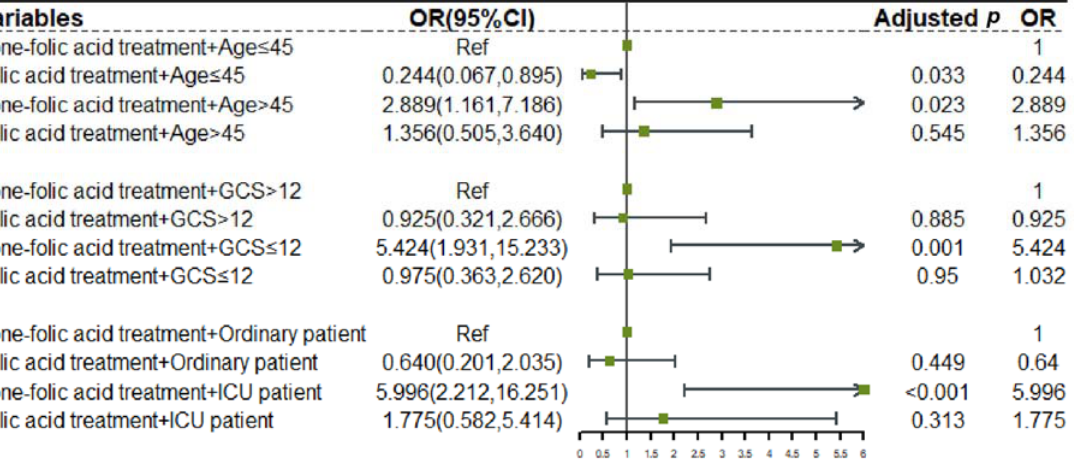
Figure 4. Forest plot of the effect of folic acid treatment. We combined folic acid treatment with other independent risk factors (Age, GCS and ICU patient) for cross-grouping and performed multivariate logistic regression analysis with mutual adjustment.